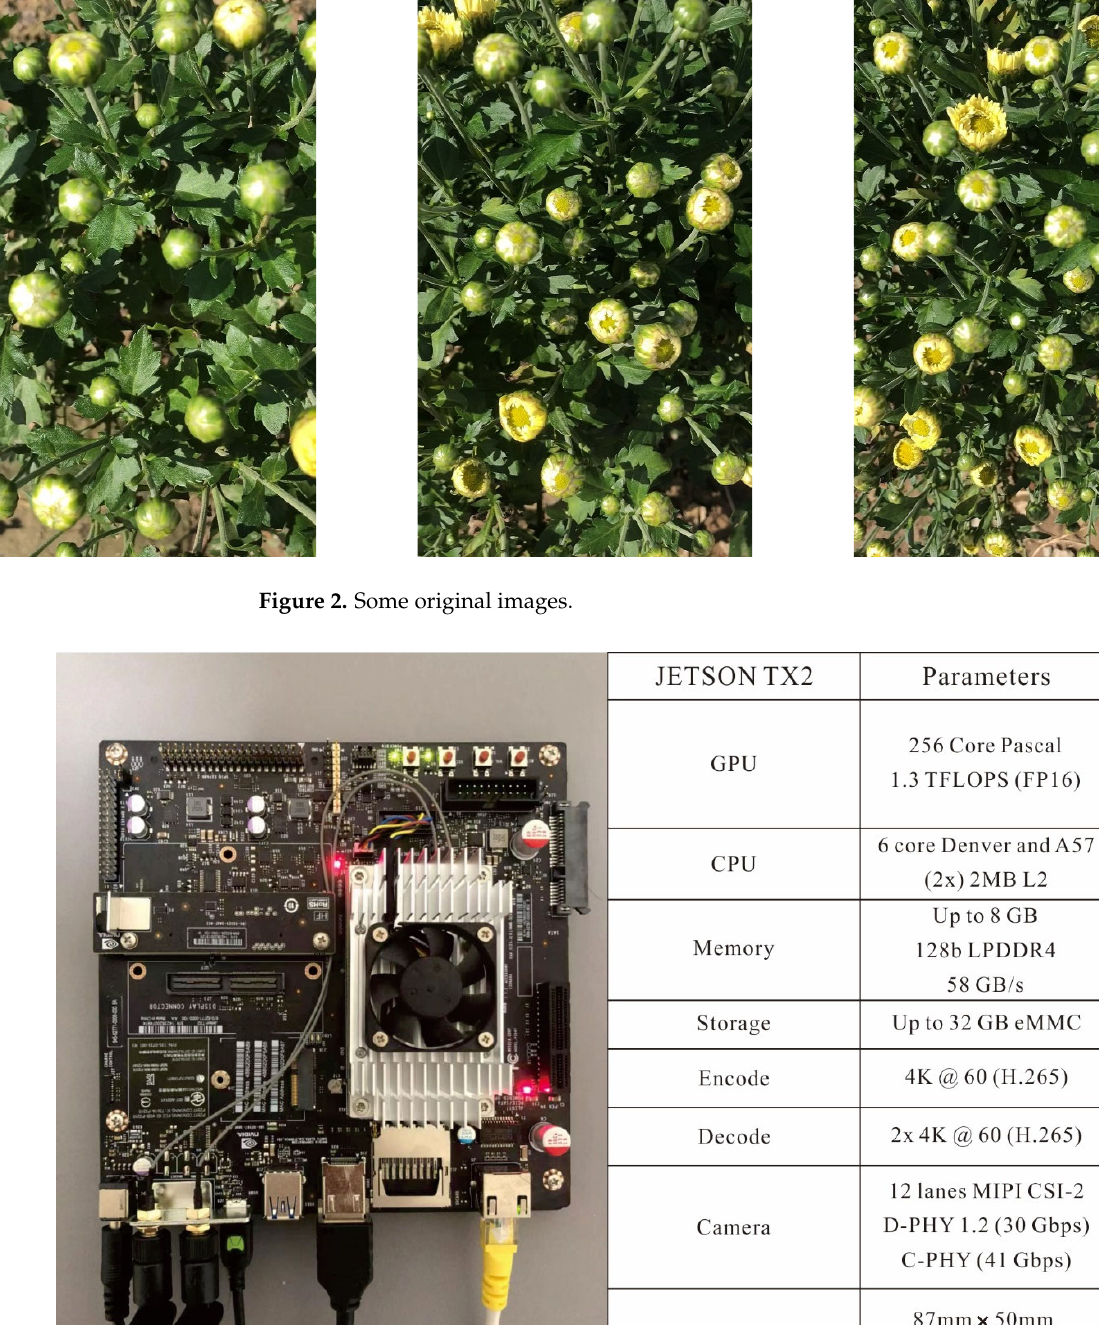
Figure 3. NVIDIA Jetson TX2 parameters.